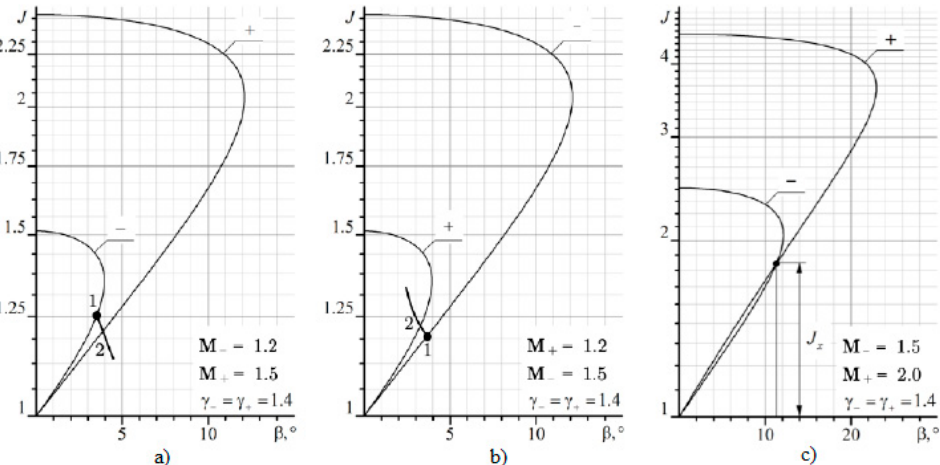
Figure 4. Three types of regular refraction on shock polar: ( a ) refraction with reflected rarefaction wave, ( b ) refraction with reflected shock wave, ( c ) characteristic refraction.